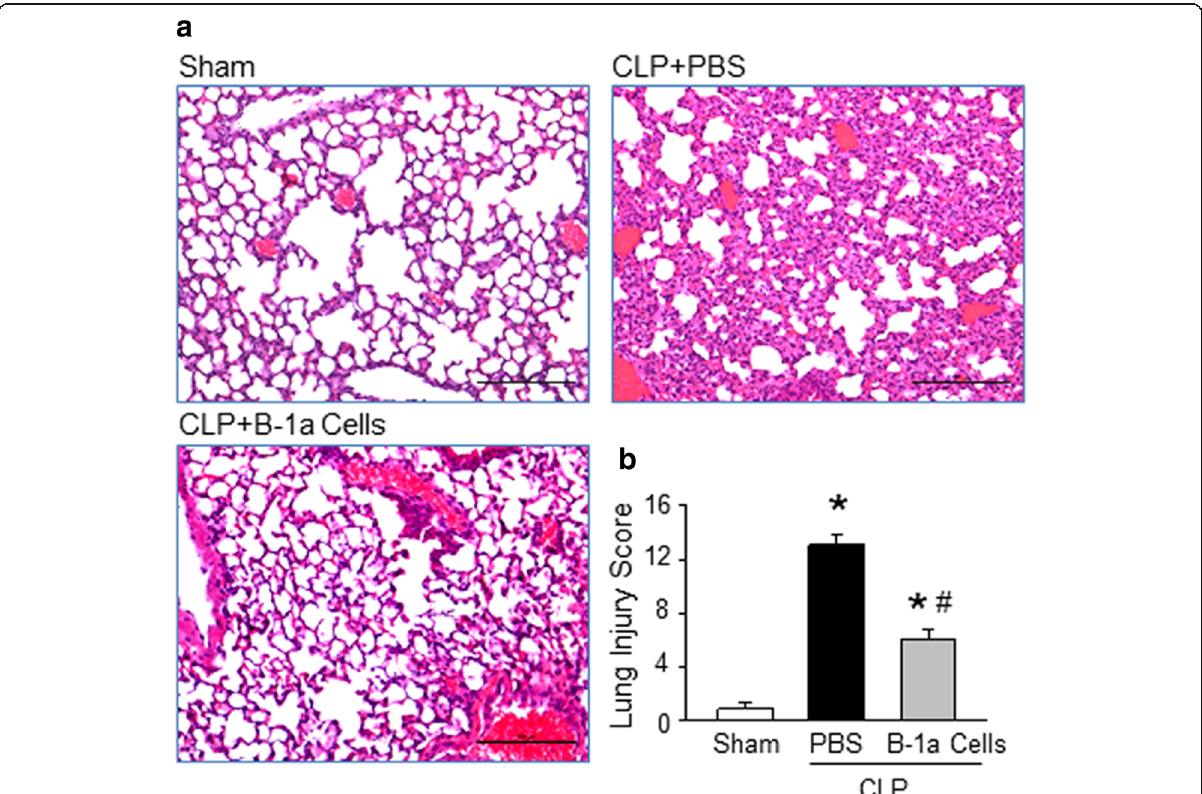
Fig. 2 Treatment with B-1a cells improves the histopathological score of lung tissue damage in sepsis. a Lung tissue was collected after 20 h from sham-operated, and either PBS- or B-1a cell-treated CLP mice and stained with H&E. Each slide was observed under light microscopy at × 100 original magnification in a blinded fashion. Representative images for each group are shown. Scale bar, 100 μ m. b Histological injury scores of the lungs in different groups were quantified as described in Materials and Methods. Data from three independent experiments are expressed as means ± SE ( n = 6 mice/group) and compared by one-way ANOVA and SNK method ( * p < 0.05 vs. shams; # p < 0.05 vs. PBS-treated CLP mice). CLP, cecal ligation and puncture; H&E, hematoxylin and